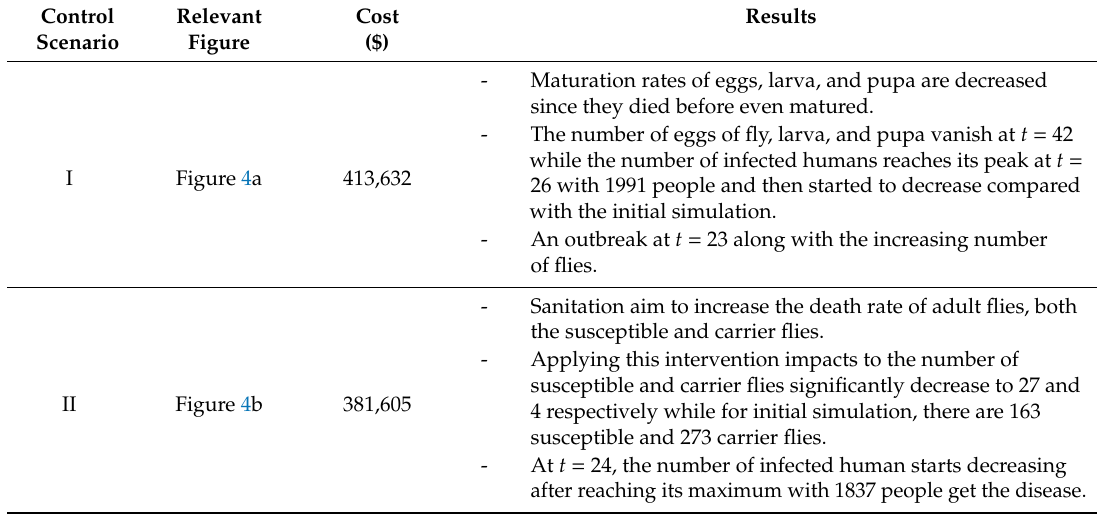
Table 7. Result of control scenario.